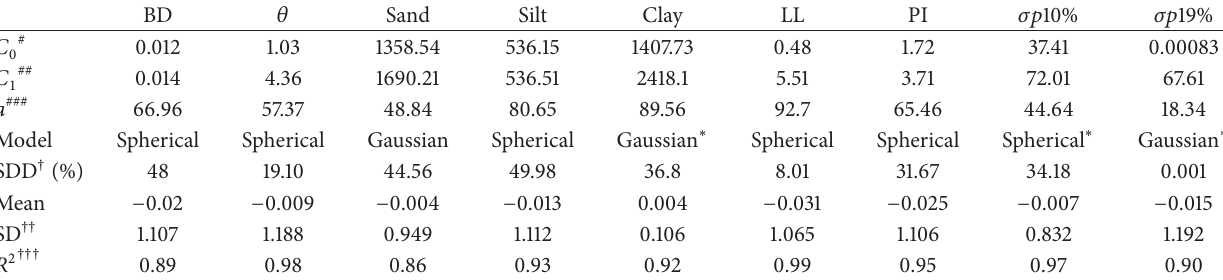
Table 5: Fitting parameters of the experimental